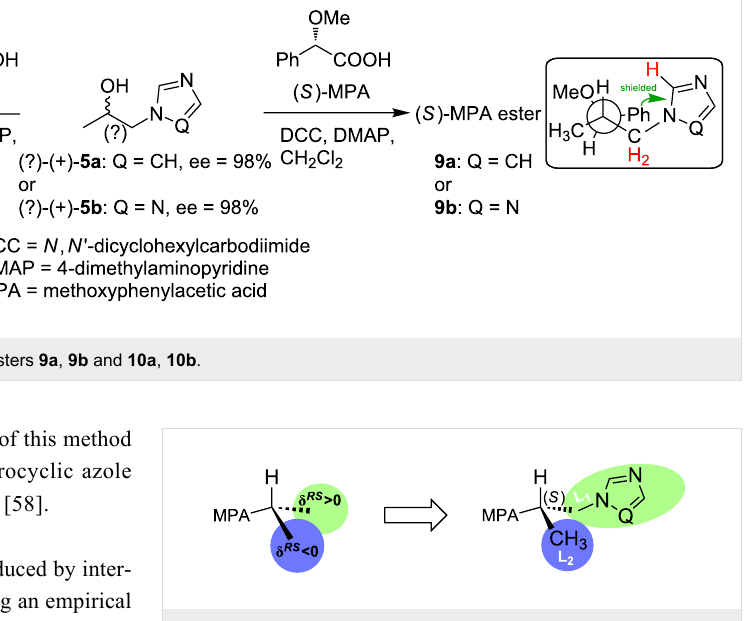
Figure 1: Model for the configurational correlation of MPA esters 9a , 9b and 10a , 10b .